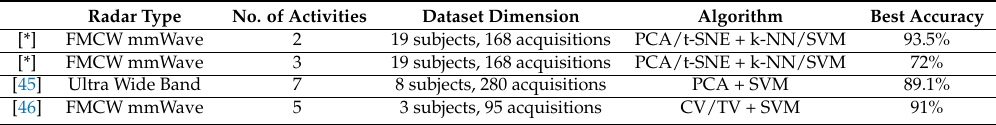
Table 5. Comparison of different radar based methods for human walking